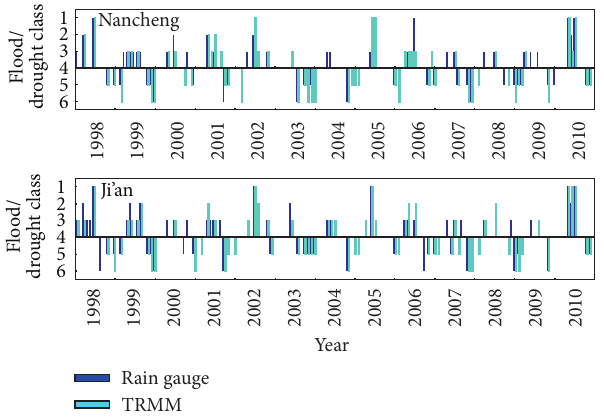
Figure4:Comparisonofflood/droughtclassbasedon 𝑍 indexusing TRMM and rain gauges data.